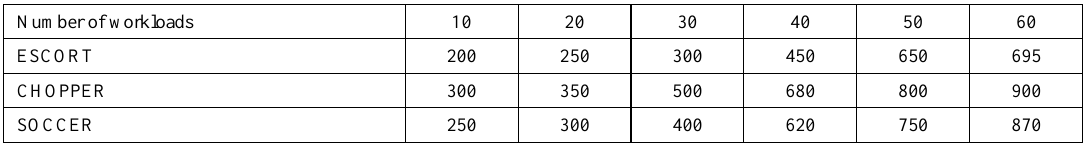
Table 4. SLA violation rate